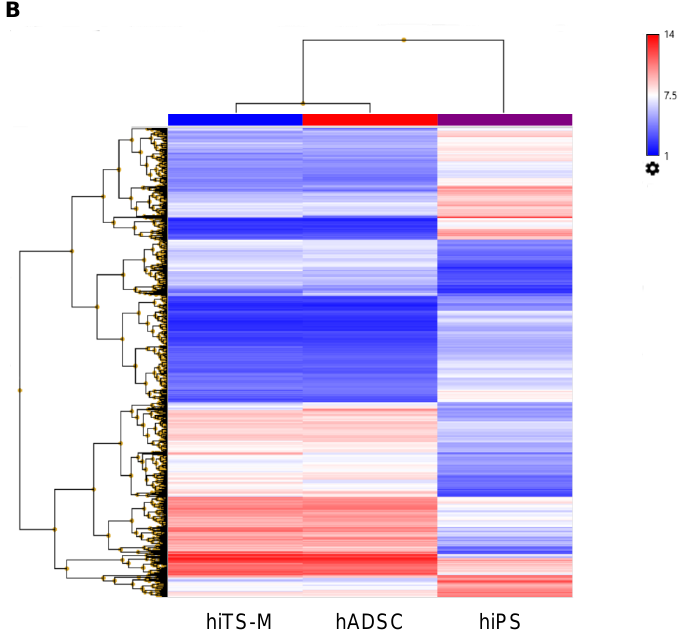
Figure 6. Microarray analysis. ( A ) A Transcriptome Analysis Console was used to analyze global gene expression patterns between hiPS cells and hiTS-M cells, between hADSCs and hiTS-M cells, and between iPS cells and hADSCs. Grey area indicates genes expressed at levels less than two-fold different between the two samples. ( B ) Unsupervised hierarchical clustering of gene expression profiles of hiPS cells, hiTS-M cells, and hADSCs. Each column represents one biological